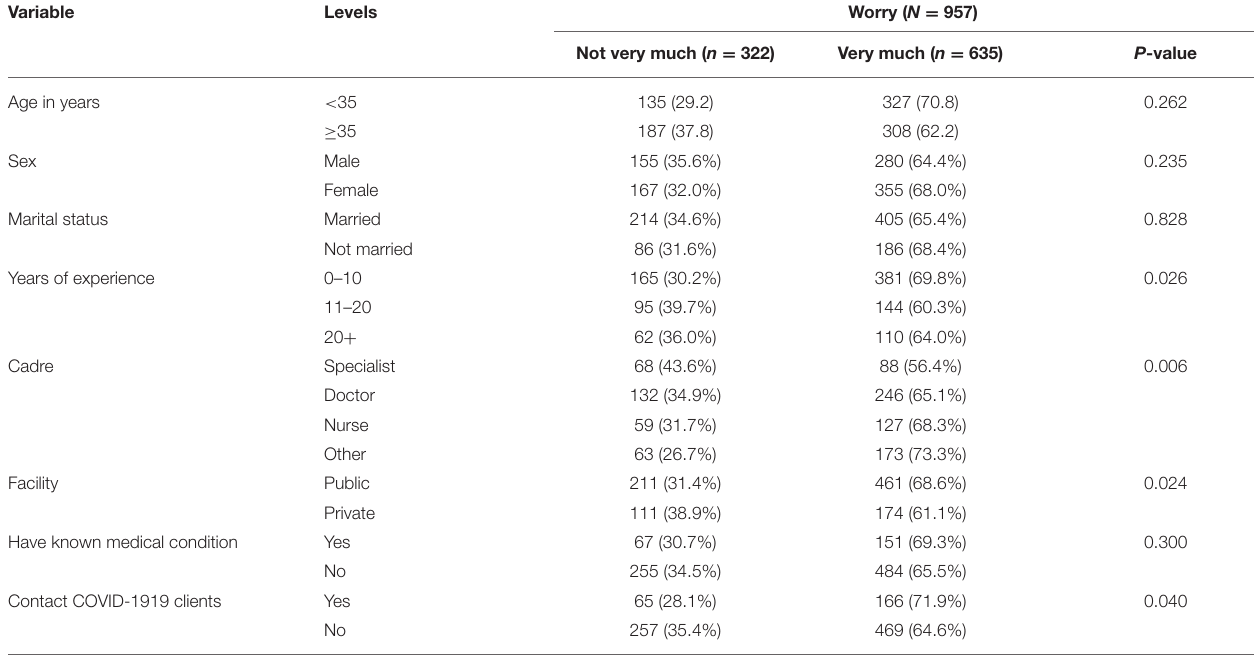
TABLE 2 | Factors associated with Worry among Healthcare workers. Variable